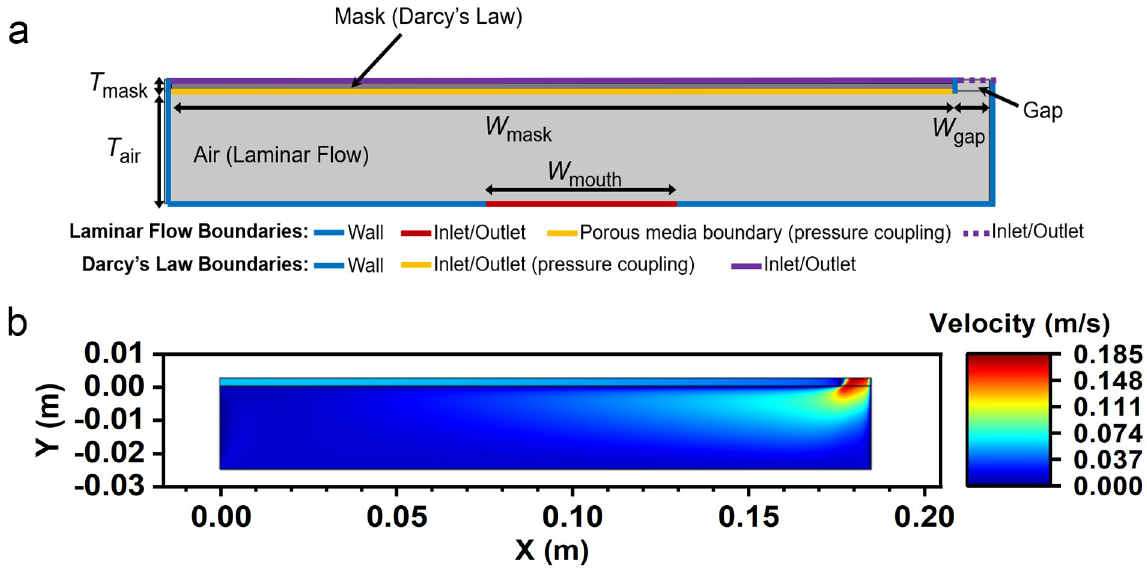
Fig 3. Schematic diagrams of the model. (a) Schematic diagram of FEM model and boundary conditions. Blue lines indicate solid walls, the red line indicates the inspiration/expiration location, the yellow line the inlet/outlet on the interior of the mask and the purple line the inlet/outlet on the mask exterior. (b) The velocity distribution during exhalation of a mask with σ = 0.05 and R = 900 Pa � s � m -1